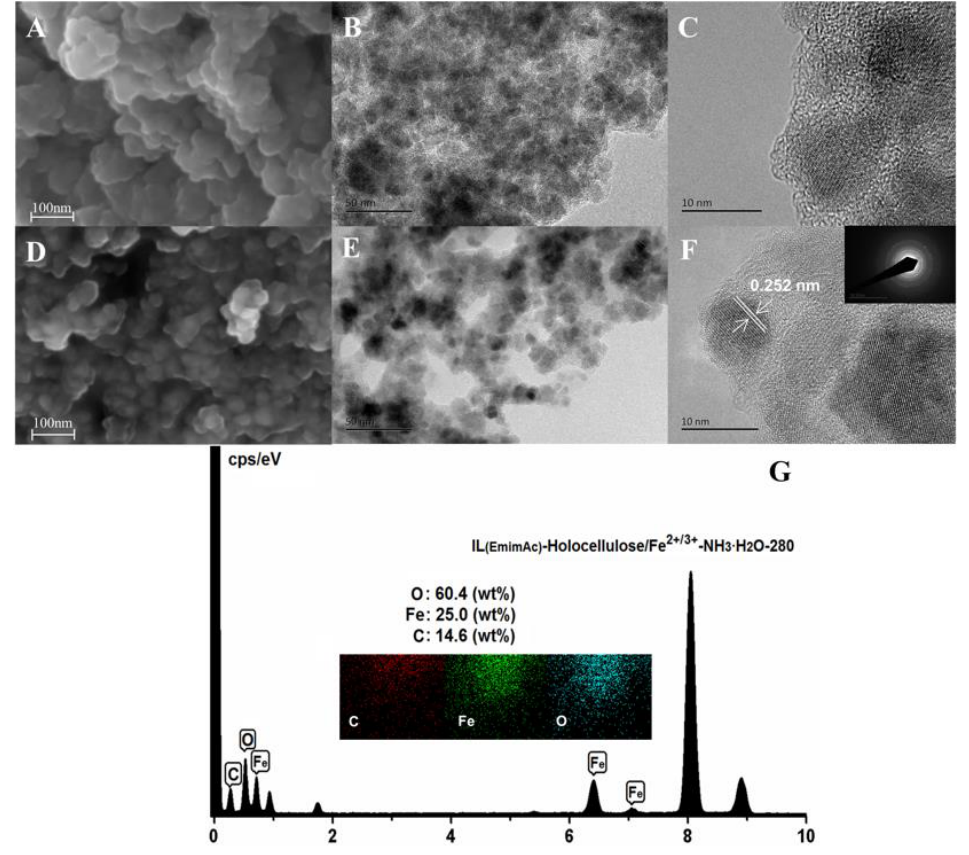
Figure 4. SEM and TEM images of the Fe 3 O 4 @C nanoparticles W NH3 -280 ( A – C ), EAc NH3 -280 ( D – F ) and EDS element (C, Fe, O) mapping ( G